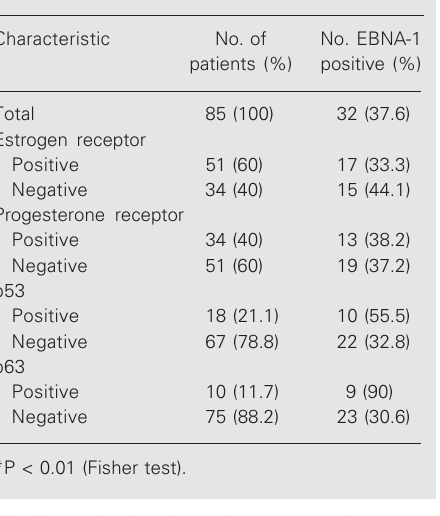
Figure 1. A , p53-positive cells in invasive ductal carcinoma (IHQ,